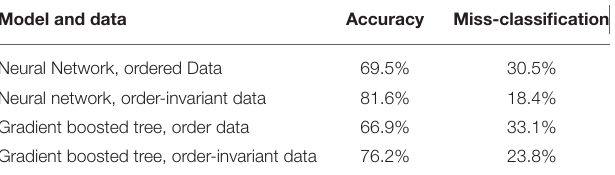
TABLE 1 | Table comparing the accuracy of pass completion prediction and the correlating miss-classification rate.